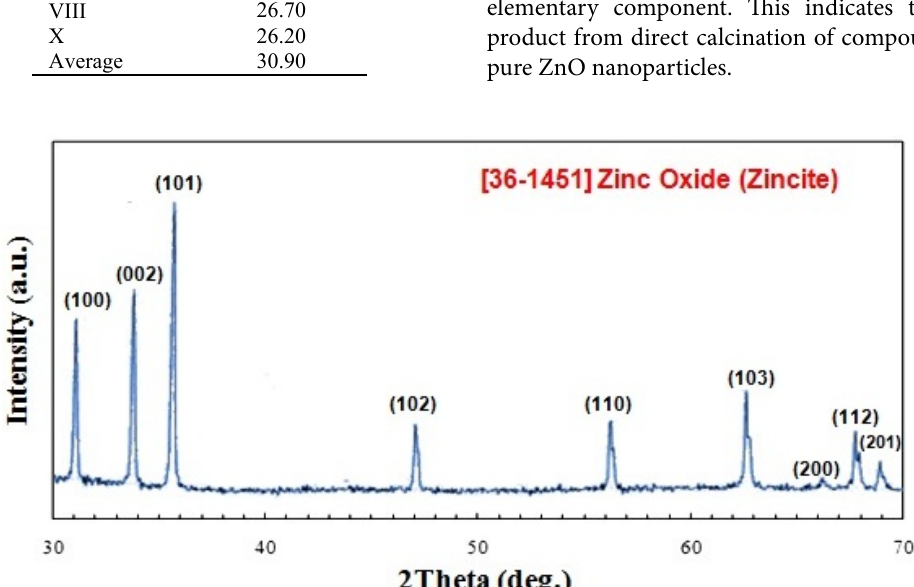
Fig. 7. XRD pattern of ZnO nanoparticles prepared by thermal decomposition of compound 1 at 600 °C